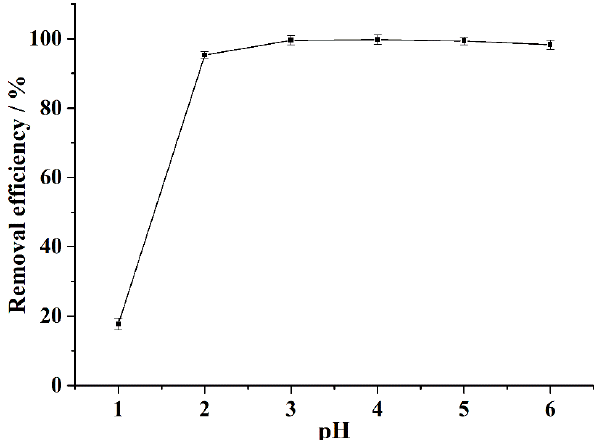
Figure 4. Influence of the solution acidity on the Pb 2+ removal efficiency of Alg–PAM.